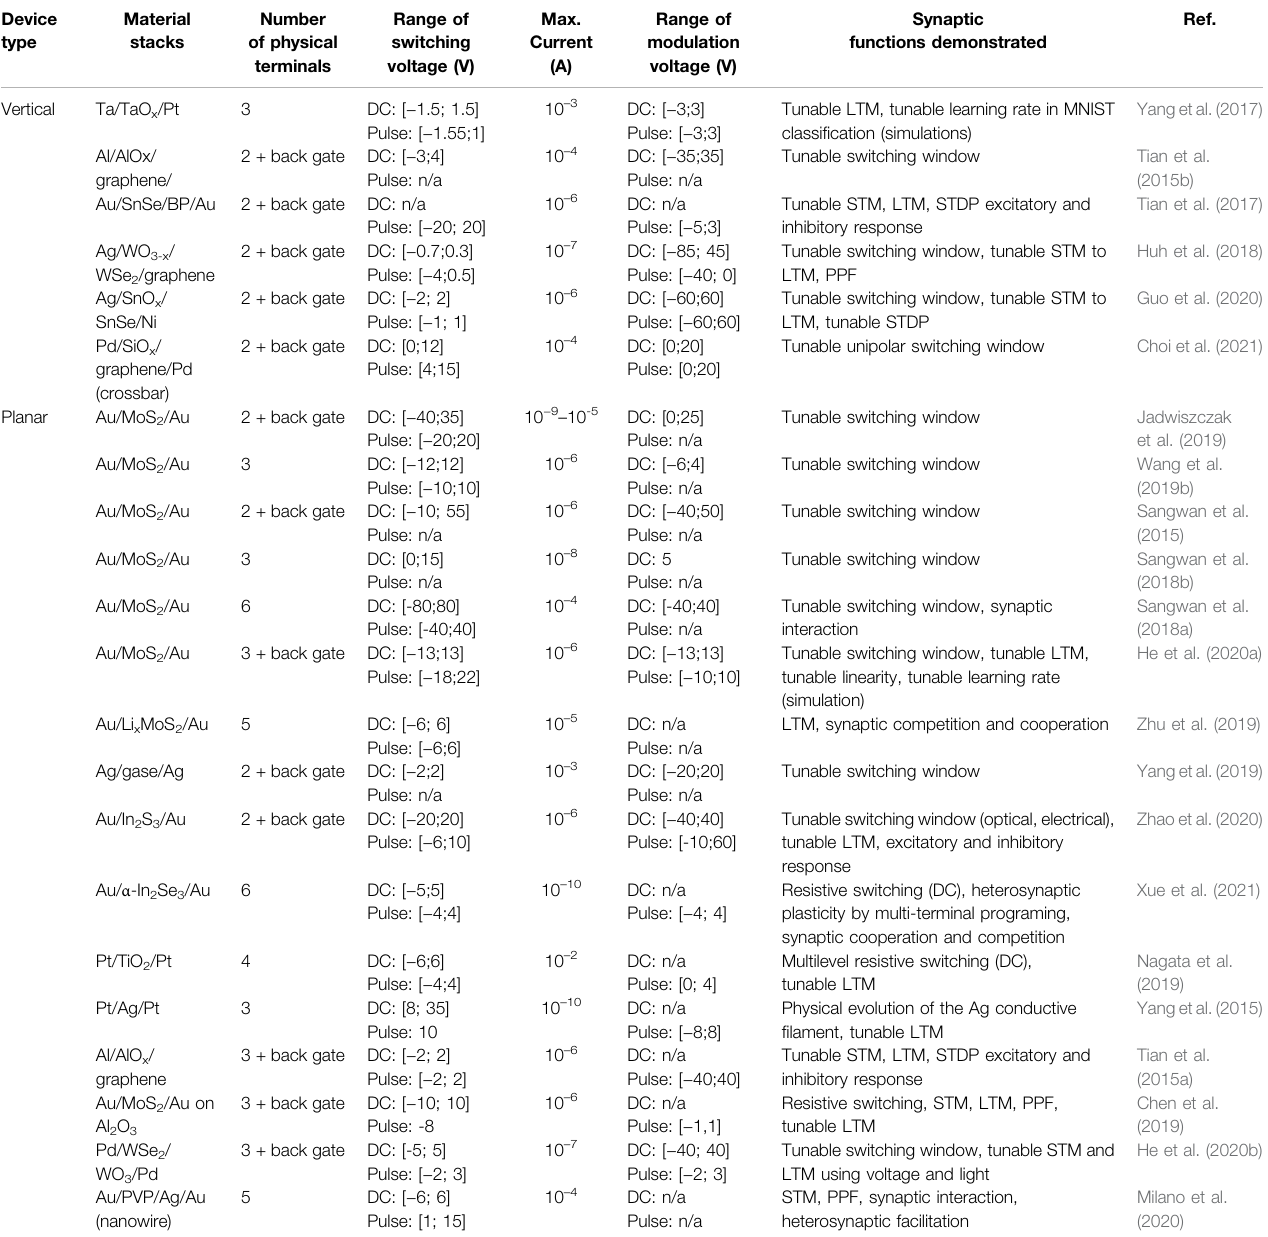
TABLE 1 | Summary of reported multi-terminal vertical and planar memristive